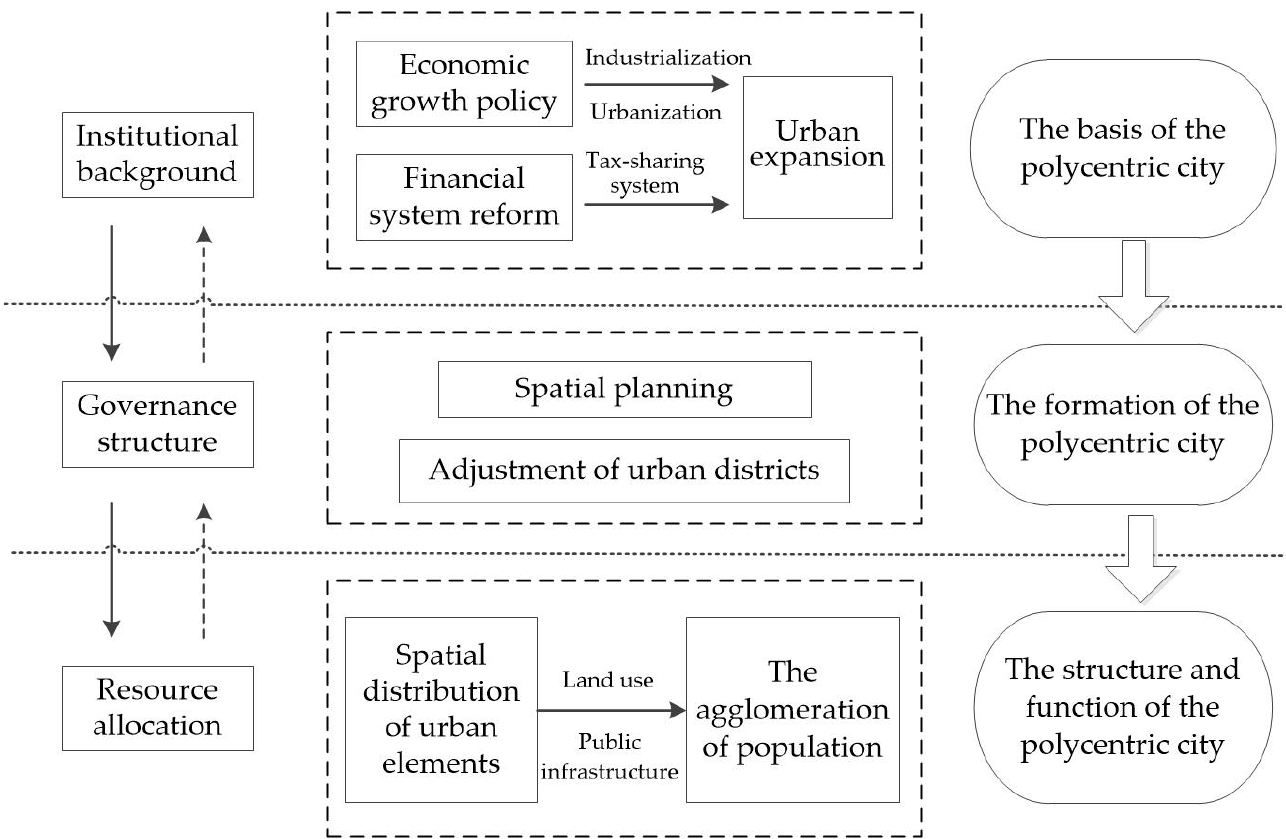
Figure 1. The theoretical framework of the research.